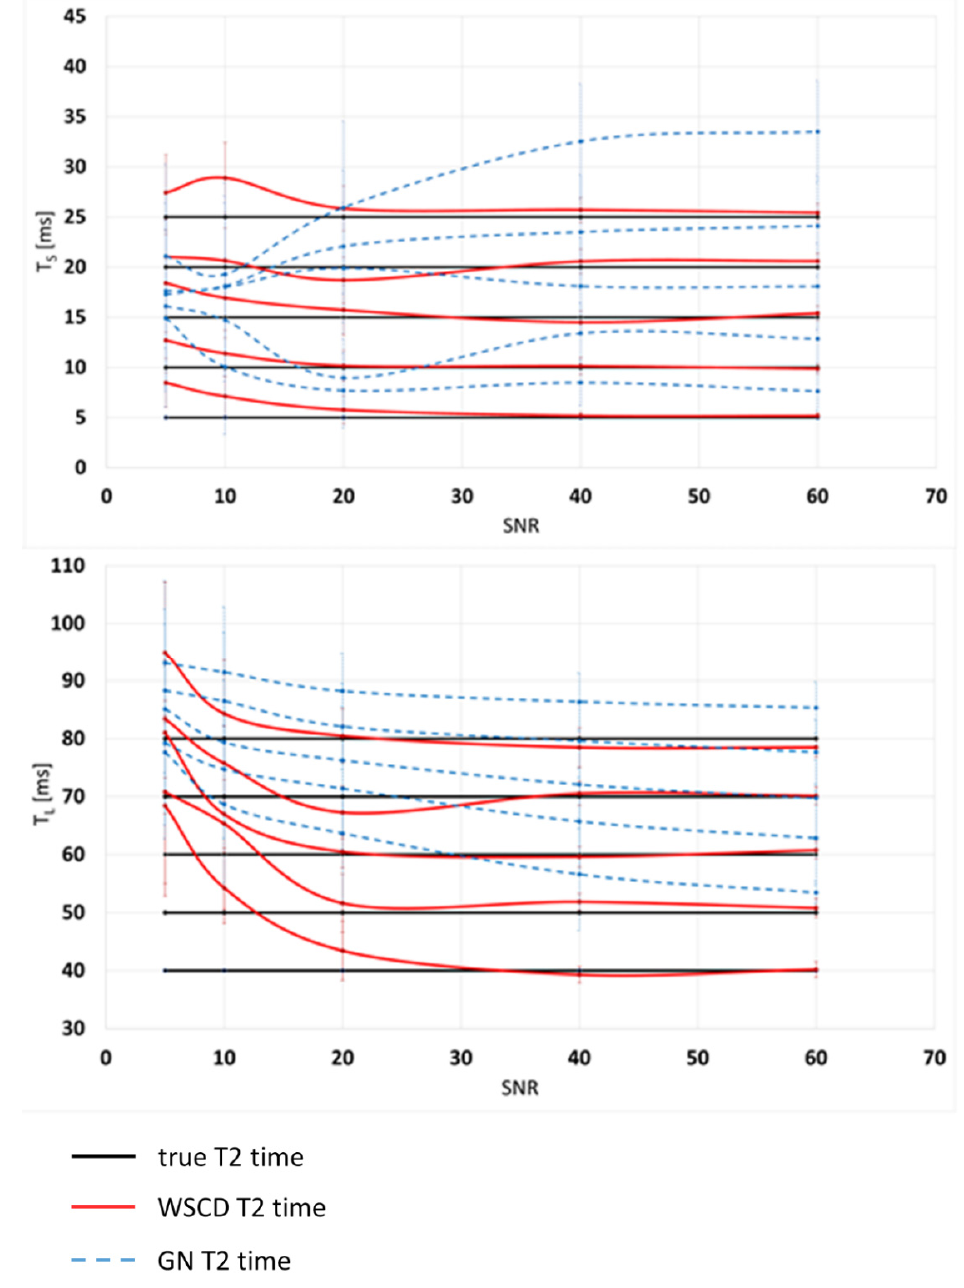
Figure 5. Accuracy of long ( T L ) and short ( T S ) T2 components from simulated data with the WSCD and GN methods. Colors: black, red, and blue denote the true T2, WSCD-reconstructed, and GN- reconstructed values, respectively. Error bars represent the SD. The reconstructed T2 values should be as close as possible to the true T S values of 5, 10, 15, 20, and 25 ms and true T L values of 40, 50, 60, 70, and 80